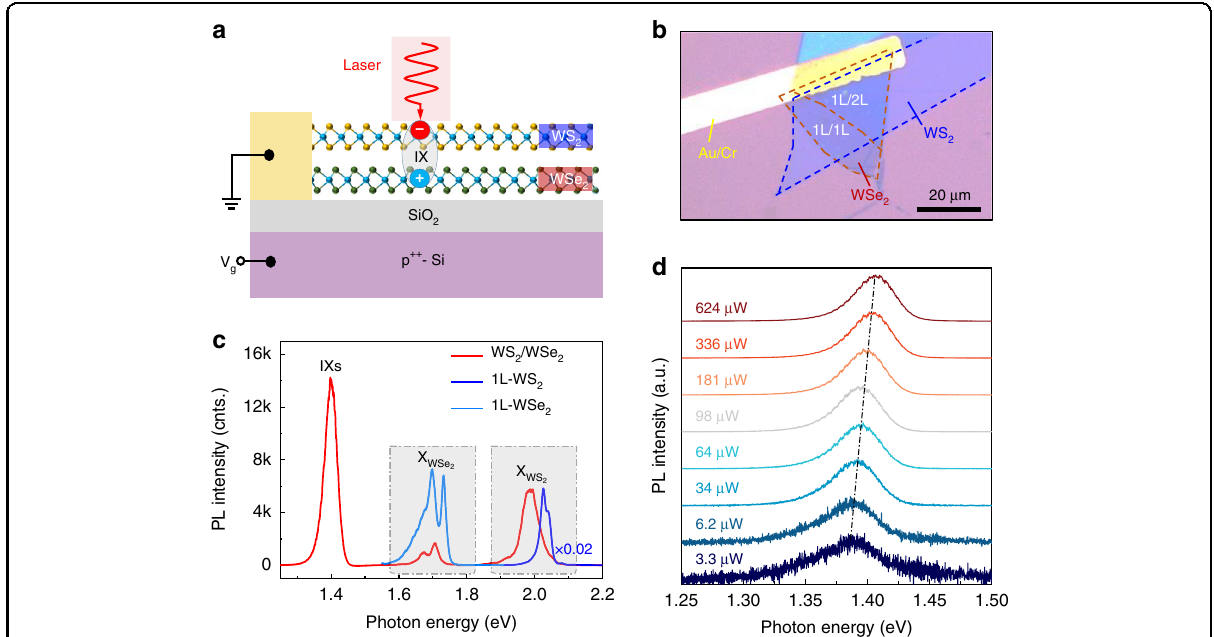
Fig. 1 IXs in a WS 2 /WSe 2 HS. a , b Schematic and optical microscope image of the device, respectively. 1L/1L and 1L/2L represents monolayer WS 2 /monolayer WSe 2 and monolayer WS 2 /bi-layer WSe 2 respectively. c PL spectra of the HS and monolayer WSe 2 and WS 2 at 78 K under 23 μ W excitation at 532 nm. For a clear visualization, the PL spectrum of individual WS 2 is multiplied by a factor 0.02. d PL spectra of the IXs as a function of excitation power under 633 nm laser excitation at 78